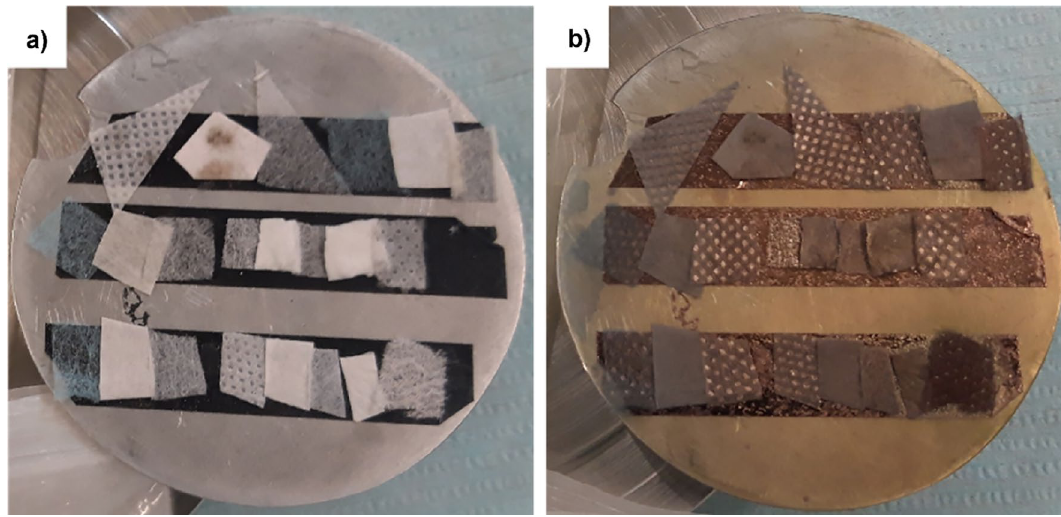
Figure 7. Face masks samples taped to a metallic stub before ( a ) and after ( b ) the gold sputtering as preparation for the SEM